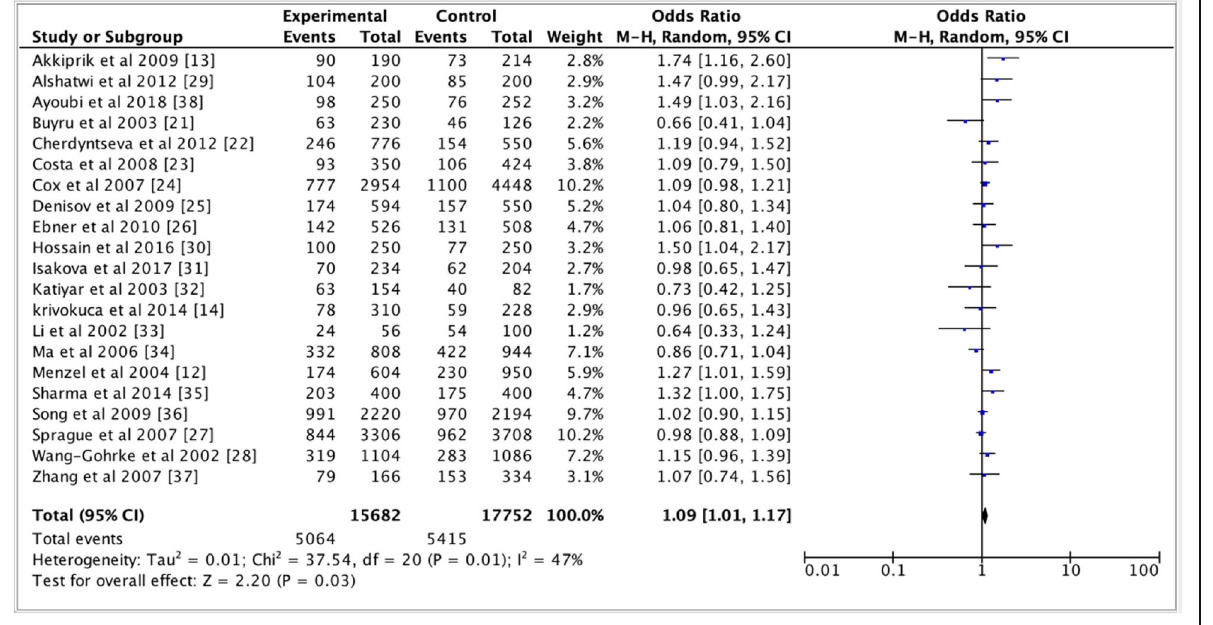
Fig. 4 Forest plots of the association between breast cancer and TP53 p.Arg72Pro polymorphism for the additive model. The black diamond denotes the pooled OR; blue squares indicate the OR in each study with square sizes inversely proportional to the standard error of the OR; and horizontal lines represent the 95%